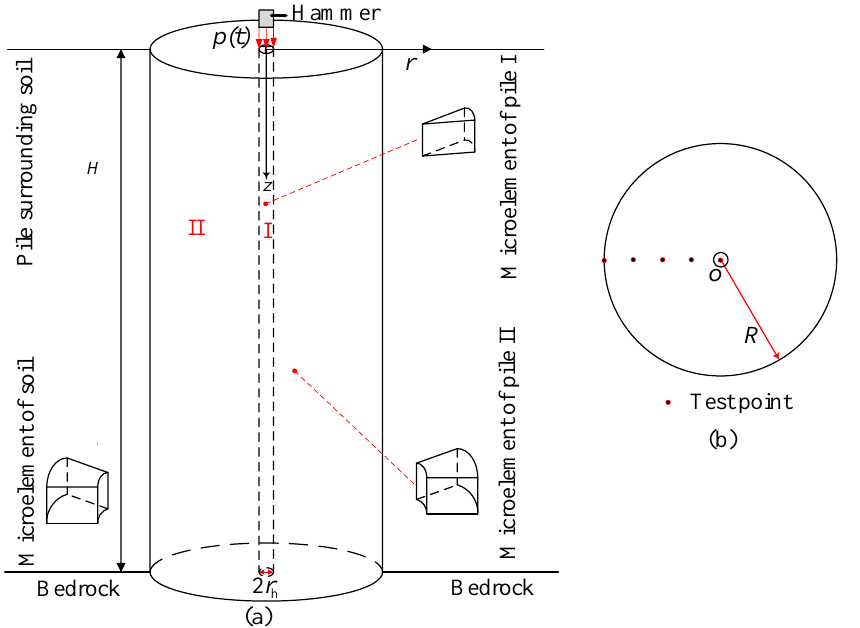
Figure 1. Computational model of the hammer-pile-soil system: ( a ) Three-dimensional model; ( b ) Top view of the pile.